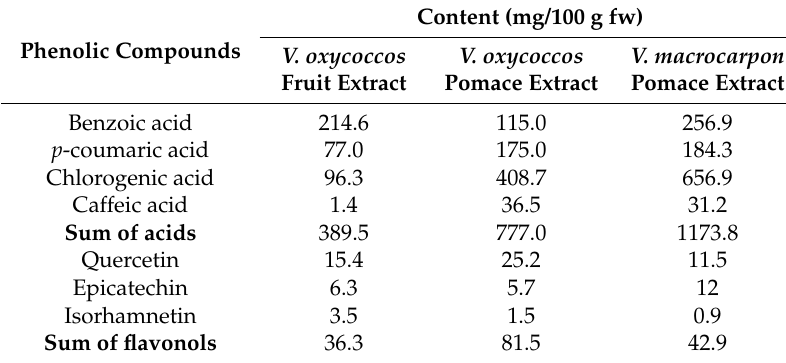
Table 2. Comparison of the polyphenolic spectrum of V. oxycoccos and V. macrocarpon fruit and pomace ethanol extracts